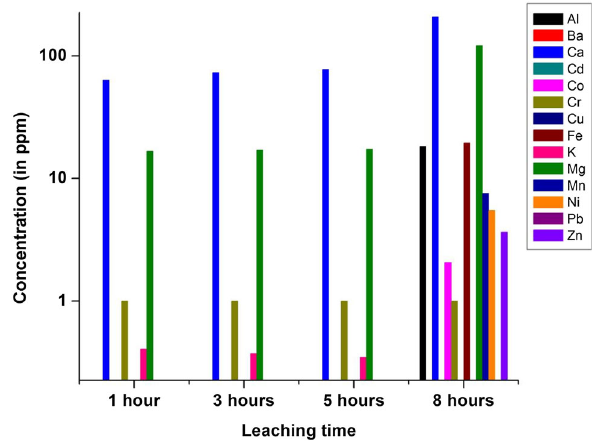
Fig. 24 Change in elemental concentration (in ppm) in aqueous leachates of Ledo coal (LC-60A) with leaching time (in hour) at 25 (cid:3) C